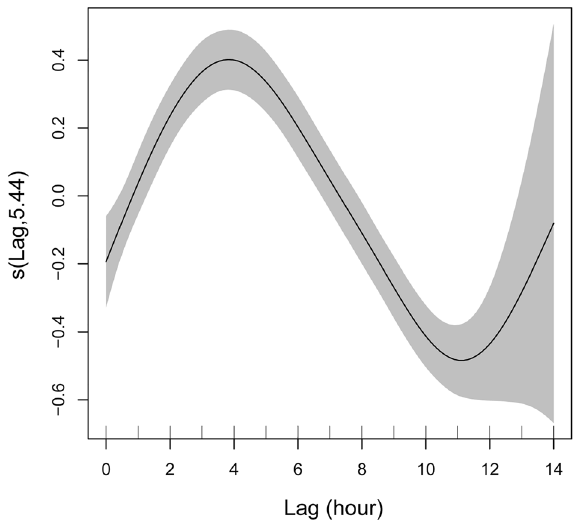
Figure 6. Relationships between the mean number of detected singers and the time lag from low tide on the west side of Chichijima Island. The x-axis shows the time lag from the low tide to the next low tide. The high tide time is 6 to 7 h after the low tide time. The scale of the smoothing effect is shown on the y-axis. A value greater than zero on the y-axis indicates a positive effect on the occurrence of singers, and a value less than zero indicates a negative effect on the occurrence of singers. The shaded area shows the 95th percentile confidence band around the smooth